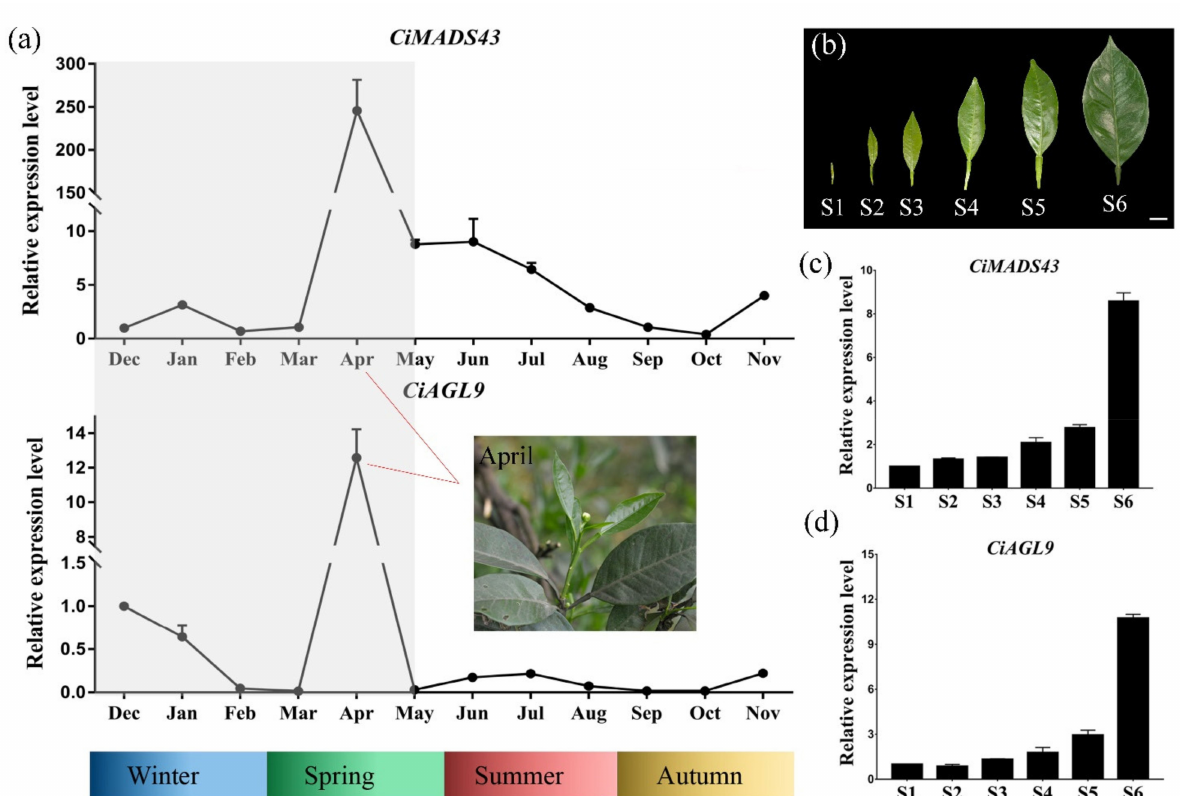
Figure 8. The expression patterns of CiMADS43 and CiAGL9 during buds and leaves development in citrus. ( a ) The seasonal expression changes of CiMADS43 and CiAGL9 in sweet orange buds. April is the flowering period of sweet orange. ( b ) The development process of sweet orange leaves was divided into six periods (S1–S6) from small to large. Scale bar = 1 cm. ( c , d ) qRT-PCR of CiMADS43 and CiAGL9 in the six periods of sweet orange leaf